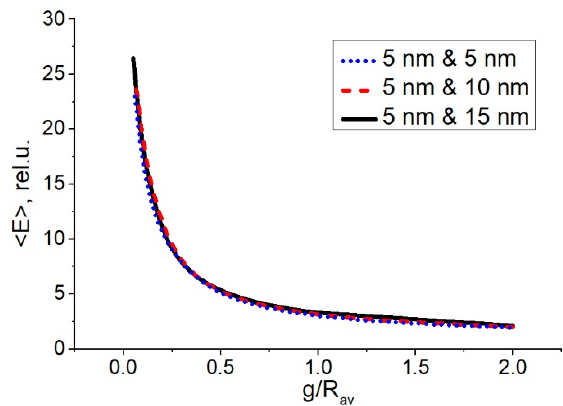
Figure 2. Dependence of the average electric field, < E >, in a gap between two particles on the interparticle gap, g , normalized by the average radius of the particles, R av . Radius of particles in pairs: 5 nm and 5 nm, 5 nm and 10 nm, 5 nm and 15 nm.